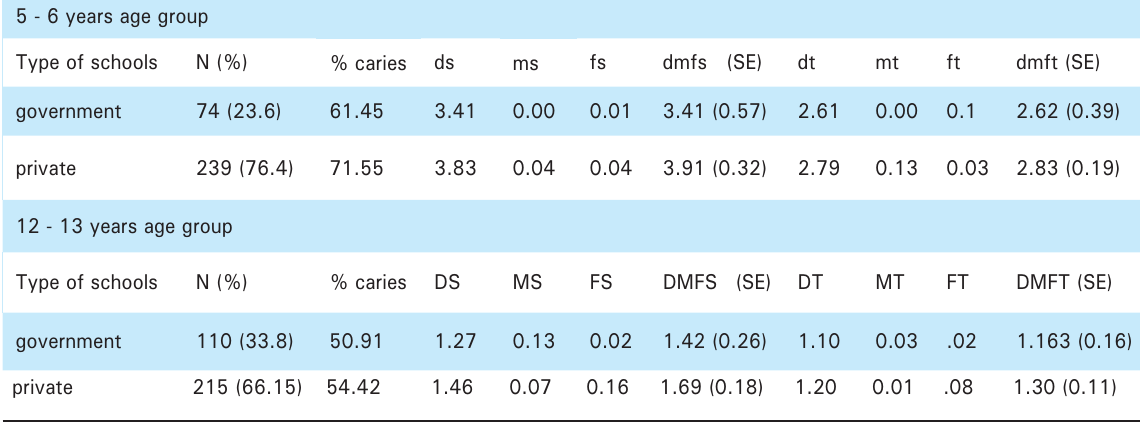
Table 3. Dental caries status in the 5 - 6 years and 12 - 13 years age group by type of school